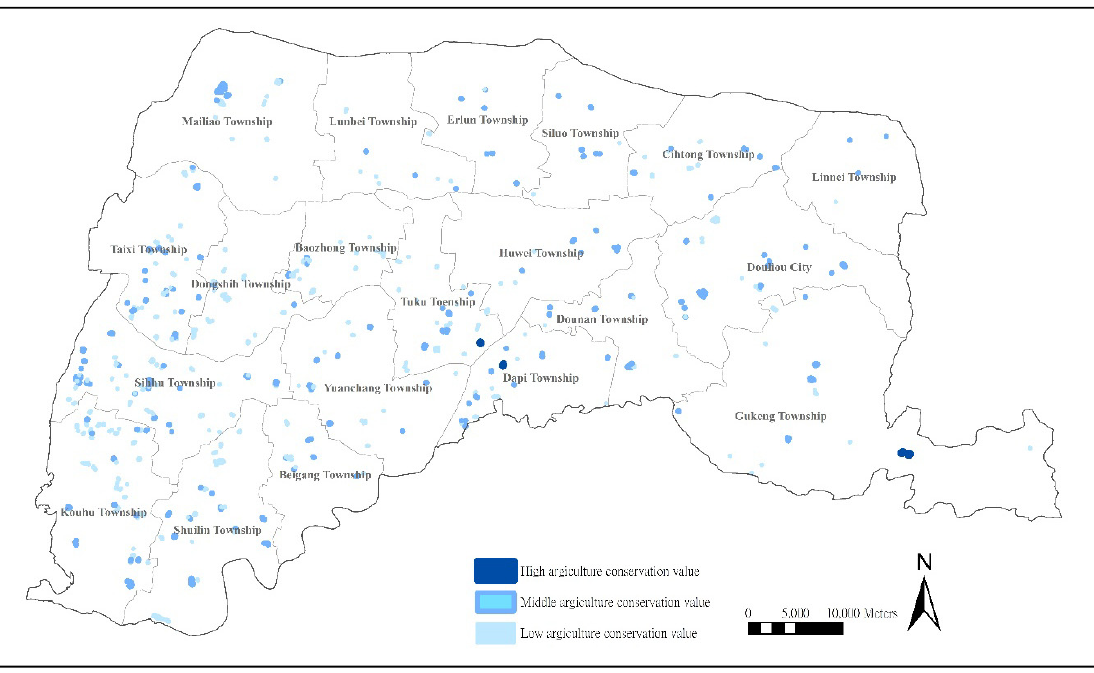
Figure 2. Distribution of farm ponds with production preservation